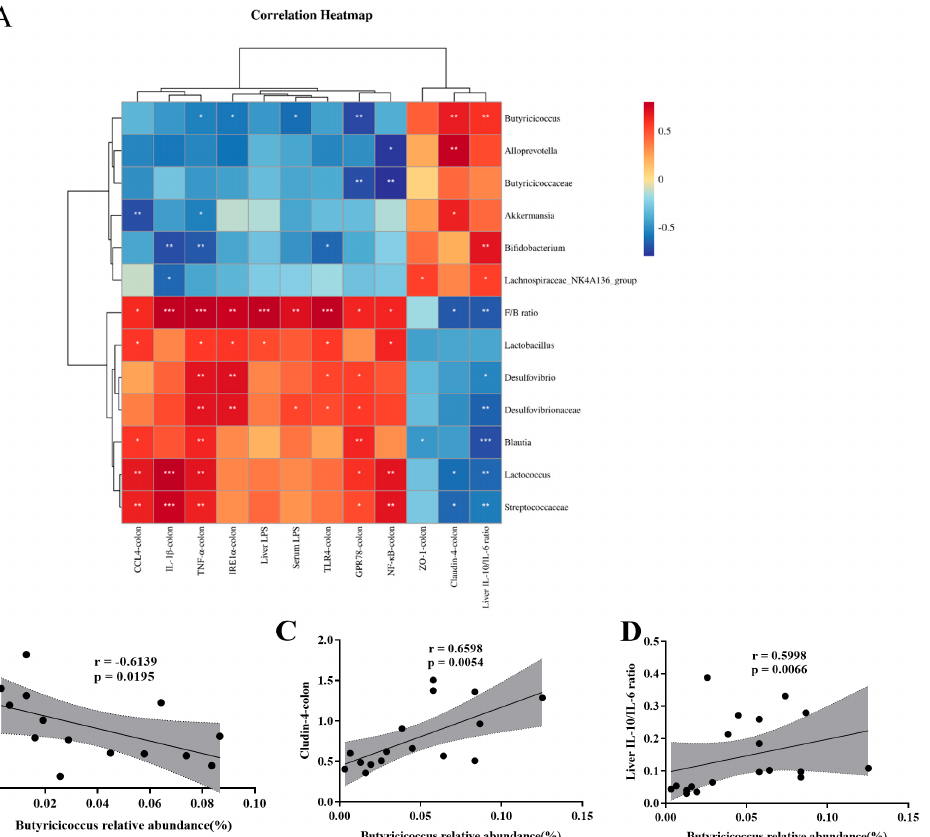
Figure 6. Spearman correlation analysis supports that SFN ameliorates HFHFr mice via the mi ‐ crobe–gut–liver axis. ( A ) Heatmap of the association between microbiota and some other experi ‐ mental results. The intensity of the color is proportional to the intensity of the Spearman correlation. ( B ) Serum LPS levels were negatively correlated with the relative abundance of Butyricicoccus . ( C ) Relative mRNA expression of Claudin ‐ 4 in the colon was positively correlated with the relative abundance of Butyricicoccus . ( D ) IL ‐ 10/IL ‐ 6 ratio in the liver measured by ELISA was positively cor ‐ related with the relative abundance of Butyricicoccus . ( E ) Serum LPS levels were positively